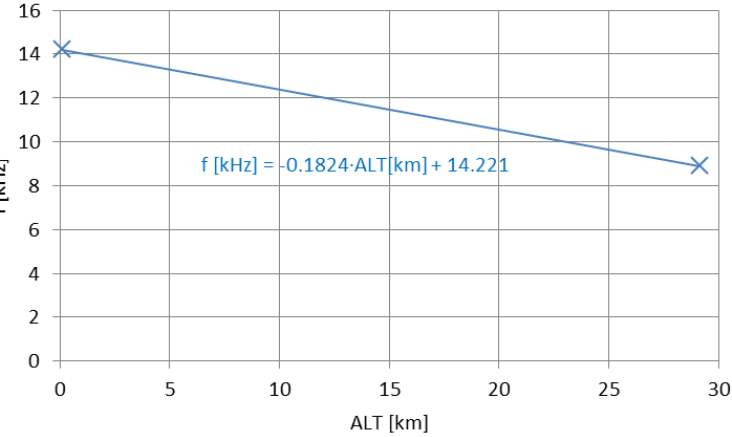
Figure 17. The apparent frequency decrease prediction function plotted for the VLF/14.2 kHz case of a fully airborne light-balloon experiment.